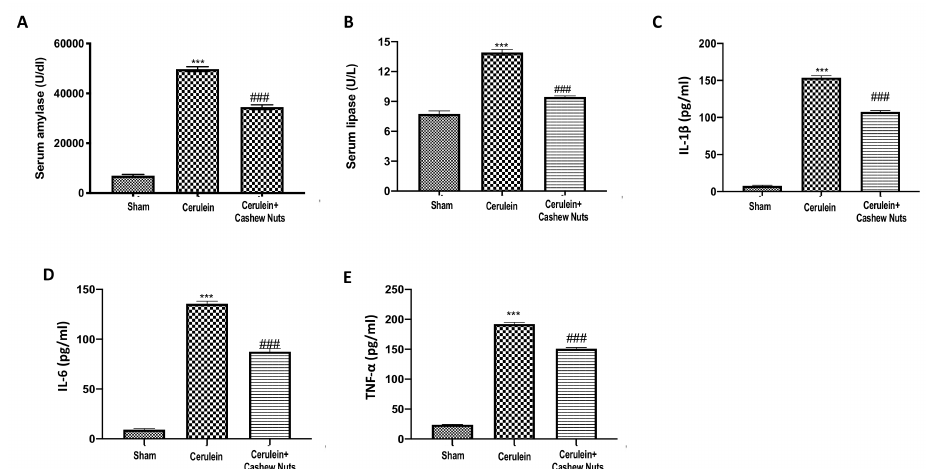
Figure 3. E ff ects of cashew nuts on the levels of amylase, lipase and cytokines in cerulein-induced AP. Amylase ( A ), lipase ( B ), IL-1 β ( C ), IL-6 ( D ), and TNF- α ( E ). Values shown are means ± SEM of 6 mice. *** p < 0.001 vs. sham; ### p < 0.001 vs. cerulein.